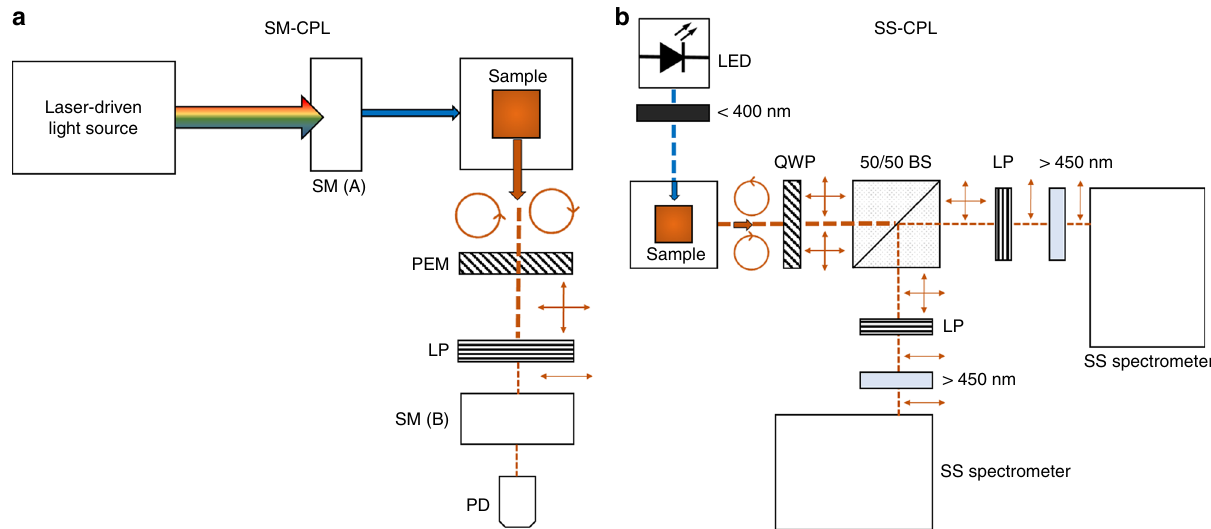
Fig. 1 Optical layouts of the CPL spectrometers. Circles with arrows represents circularly polarised light; vertical and horizontal arrows represent linearly polarised light. a SM-CPL spectrometer. Laser driven light source. SM(A) = excitation scanning monochromator; PEM = photoelastic modulator (effectively acting an electrically switched variable quarter wave plate operating at radio frequencies); LP = linear polariser; SM(B) emission scanning monochromator; PD = photodiode. b SS-CPL spectrometer. LED = light emitting diode (emission peak at 365 nm); <400 nm = short pass fi lter; QWP = quarter wave plate; 50/50 BS = 50/50 non-polarising beam splitter; LP = linear polariser; >450 nm = long pass fi lter; SS spectrometer = solid state CCD